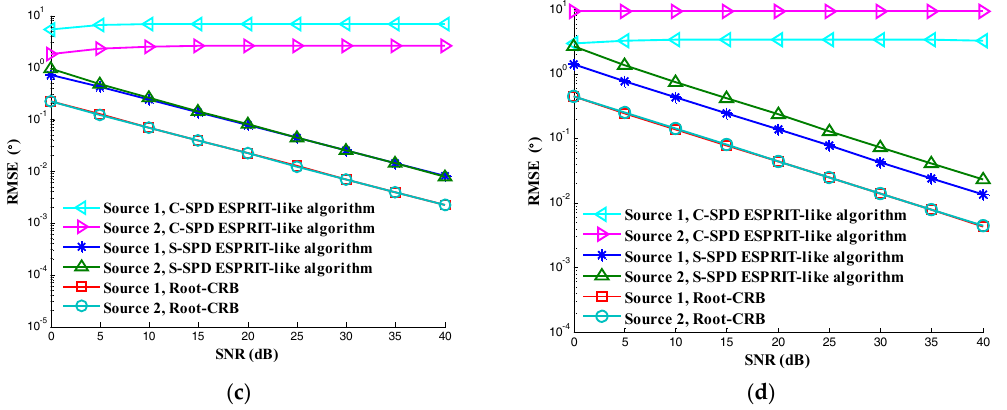
Figure 8. Test of anti mutual coupling: ( a ) Elevation; ( b ) Azimuth; ( c ) Auxiliary polarization angle; ( d ) Polarization phase difference.